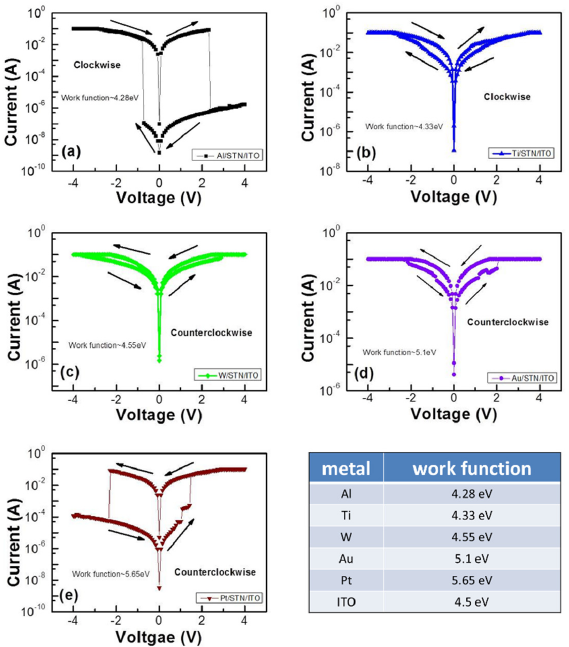
Figure 1. Typical switching current ‐ voltage (I ‐ V) curves of ( a ) Al/strontium titanate nickelate/indium tin oxide (Al/STN/ITO); ( b ) Ti/STN/ITO; ( c ) W/STN/ITO; ( d ) Au/STN/ITO; and ( e ) Pt/STN/ITO structures in bipolar resistive switching mode. The work functions of the used materials are also shown.